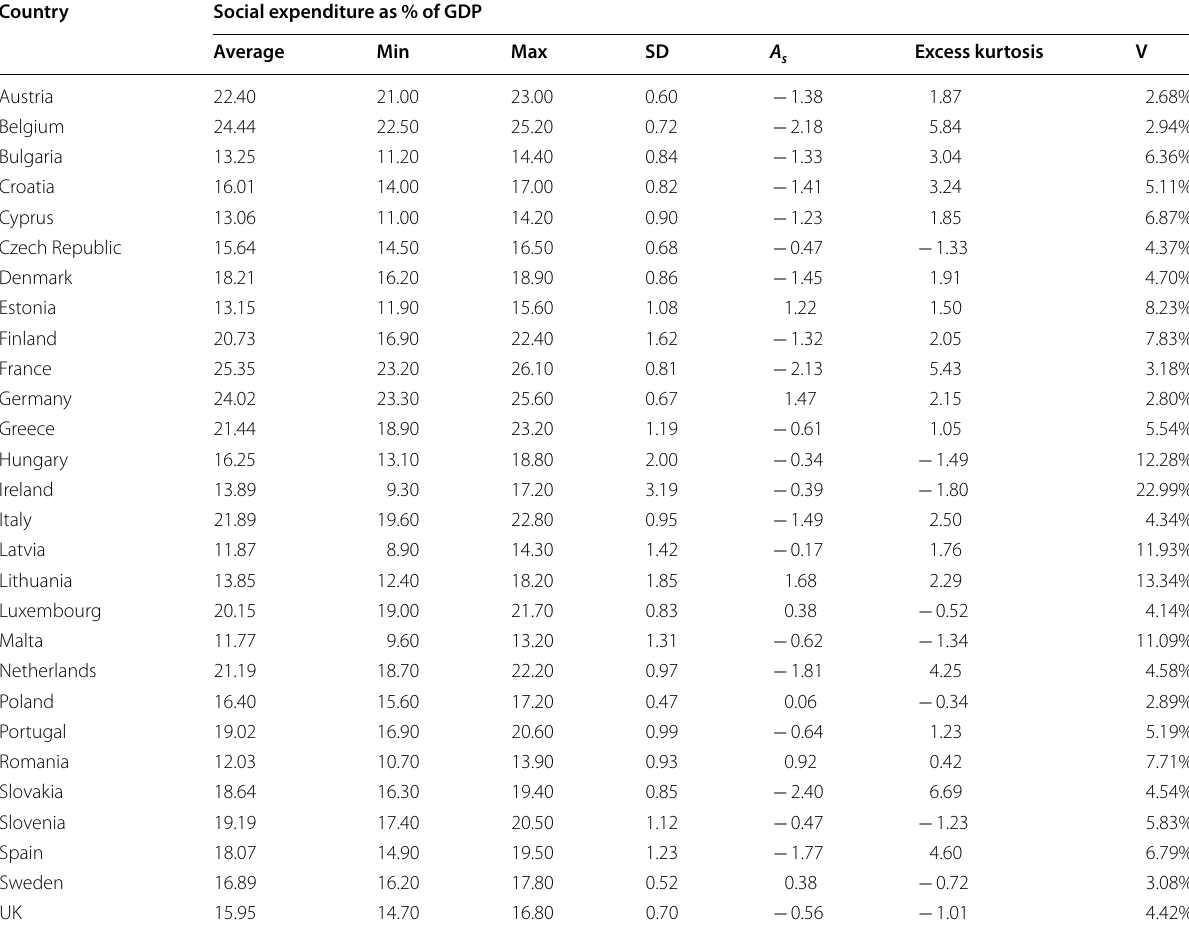
Source Own calculation based on Eurostat